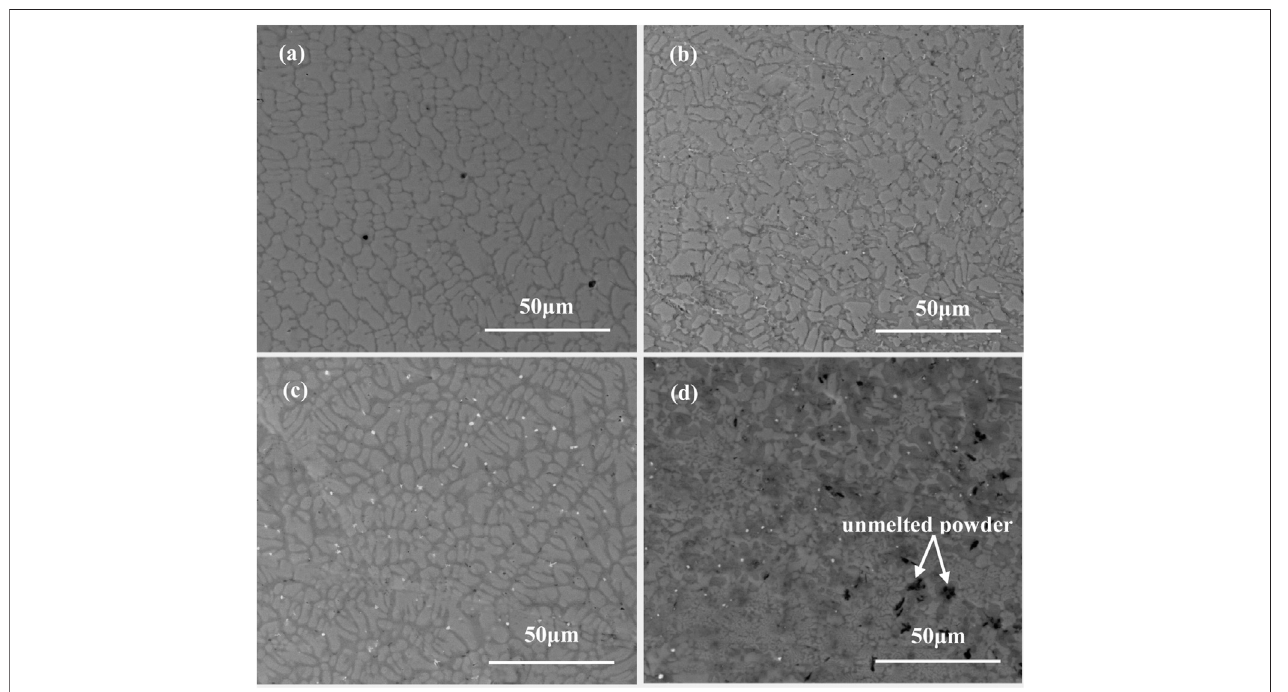
FIGURE 3 | Cross-sectional morphologies of the as-deposited coatings near the interface: (A) 0 wt% Sm 2 O 3 ; (B) 1 wt% Sm 2 O 3 ; (C) 3 wt% Sm 2 O 3 ; (D) 5 wt% Sm 2 O 3